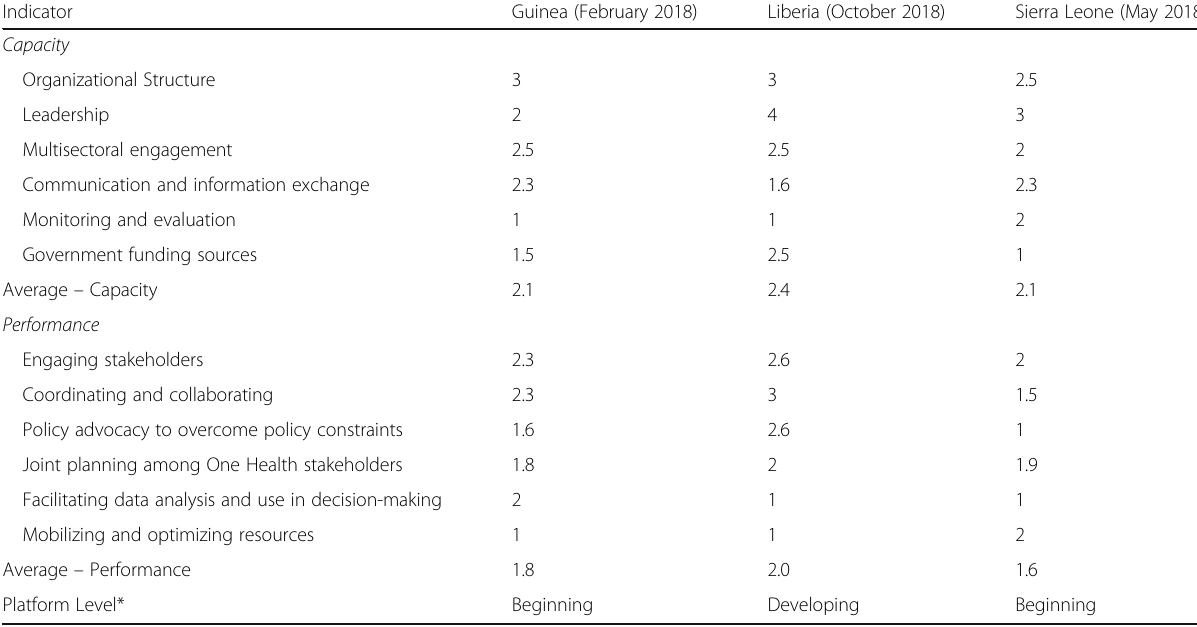
Table 5 One Health Assessment for Planning and Performance Results in Guinea, Liberia, and Sierra Leone